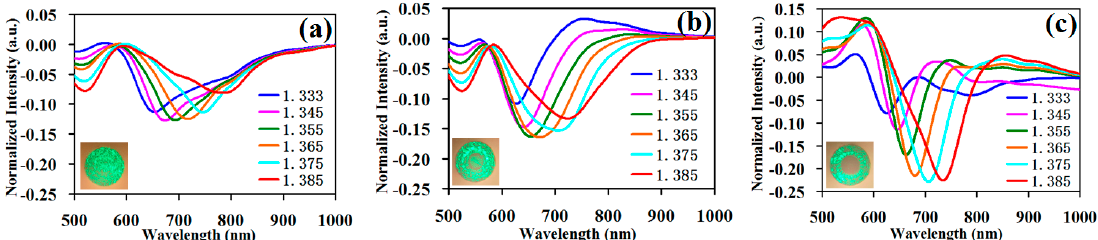
Figure 5. The testing data of all kinds of fiber cladding SPR sensors. ( a ) The testing data of the single-mode fiber cladding SPR sensor; ( b ) the testing data of the gradient refractive index multimode fiber cladding SPR sensor; ( c ) the testing data of the step refractive index multimode fiber cladding SPR sensor.